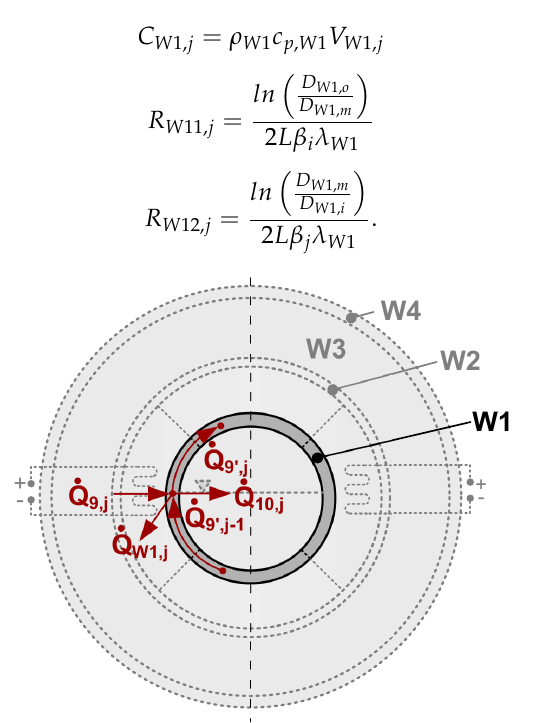
Figure 3. Sub-model: